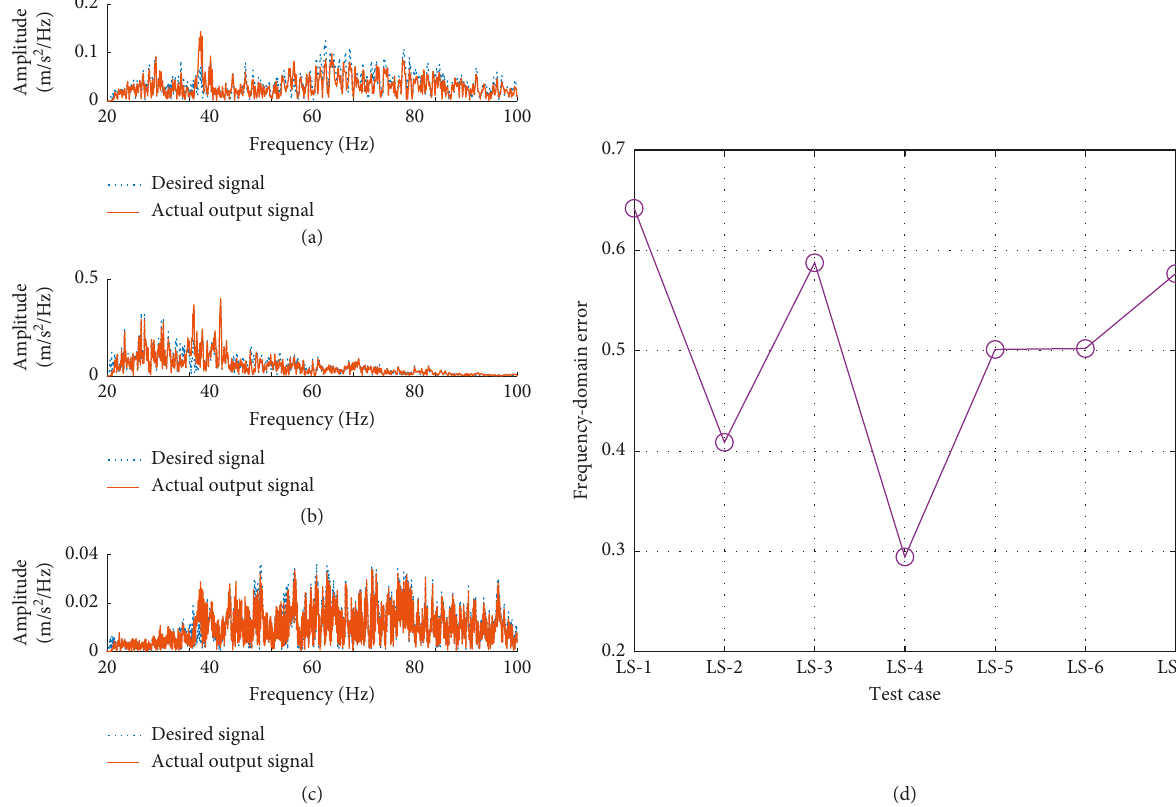
Figure 11: Desired signal and actual output signal frequency-domain comparison and error. (a) Case LS-1; (b) case LS-3; (c) case LS- 5; (d) frequency-domain error of test cases.